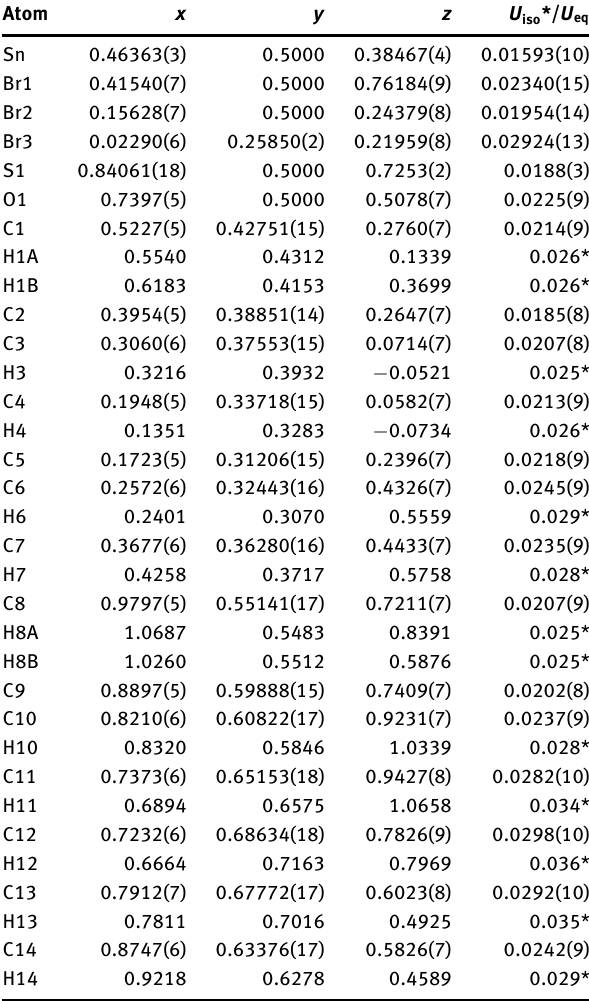
Table 2: Fractional atomic coordinates and isotropic or equivalent isotropic displacement parameters (Å 2